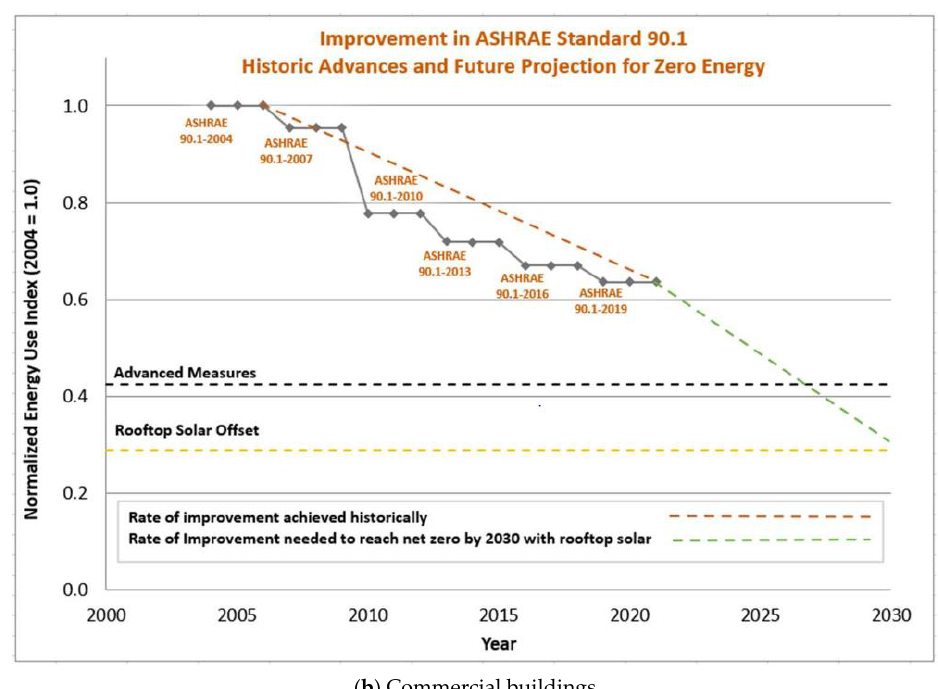
Figure 2. Chronological estimate of the performance of various codes [13] . Reproduced with permission from Battelle Memorial Institute, 2022.